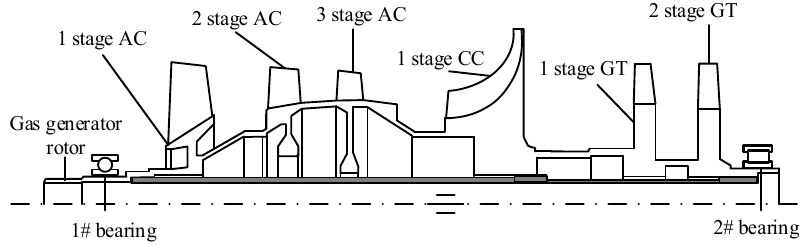
Figure 1. Schematic diagram of the turboshaft engine used gas generator rotors.